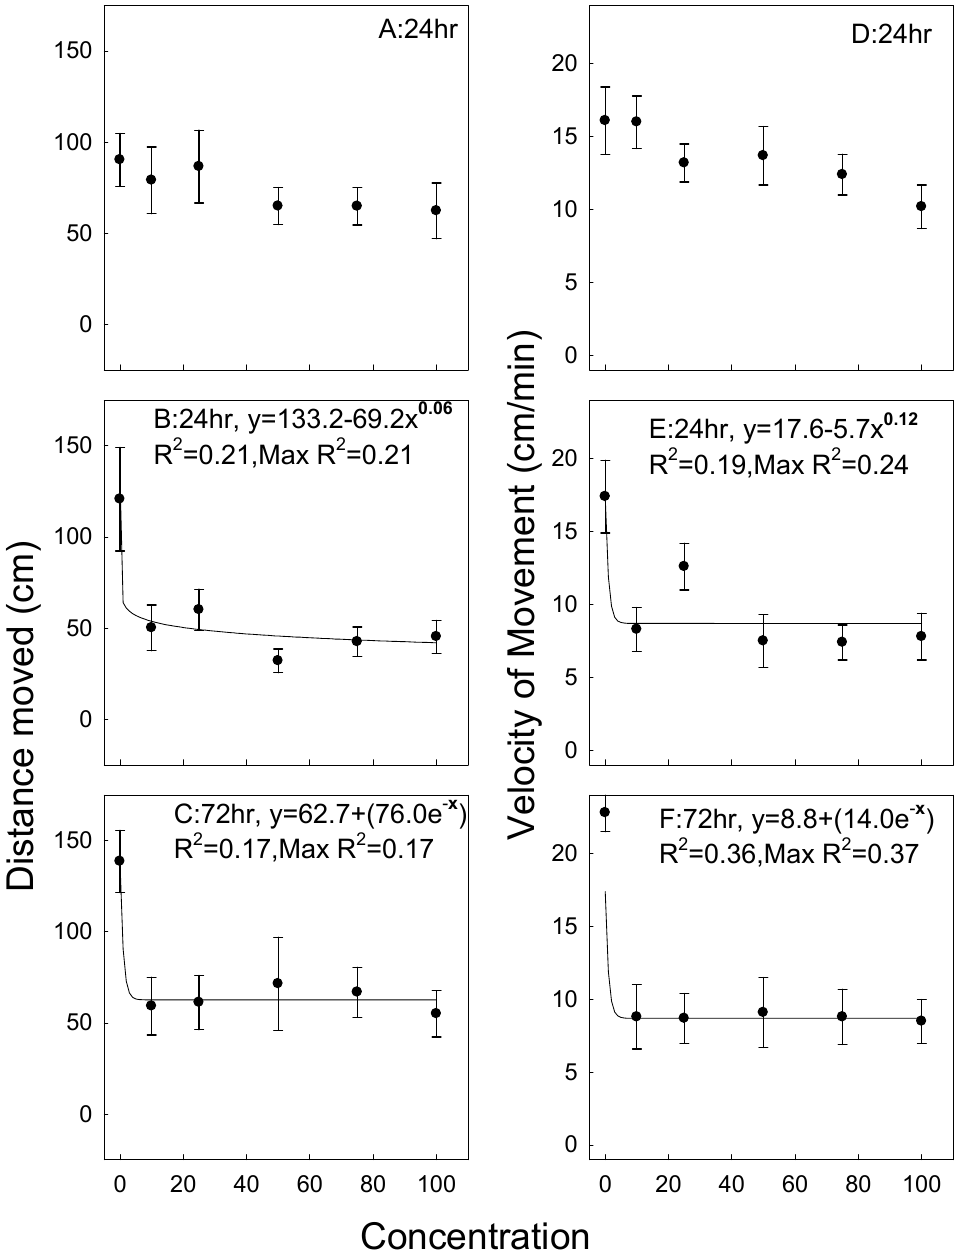
Figure 3. Distance moved for S. oryzae exposed for 1, 24, and 72 h on wheat treated with the experimental formulation (Figure 3A–C), and velocity of movement exposed at the same times (Figure 3D–F). Curve-fit lines are as described for Figure 1.